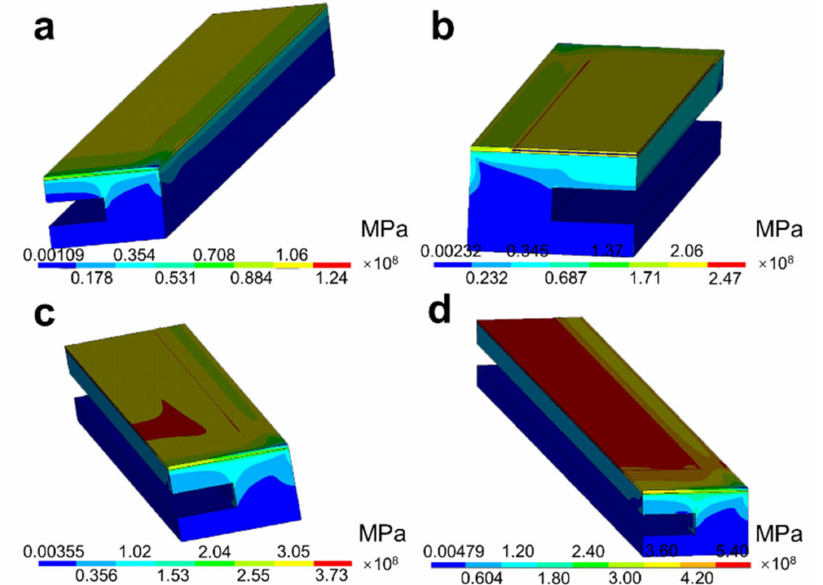
Figure 6. Thermal stress distribution of the nitrogen–oxygen sensors under different heating temper- atures: ( a ) 200; ( b ) 400; ( c ) 600; ( d ) 800 ◦